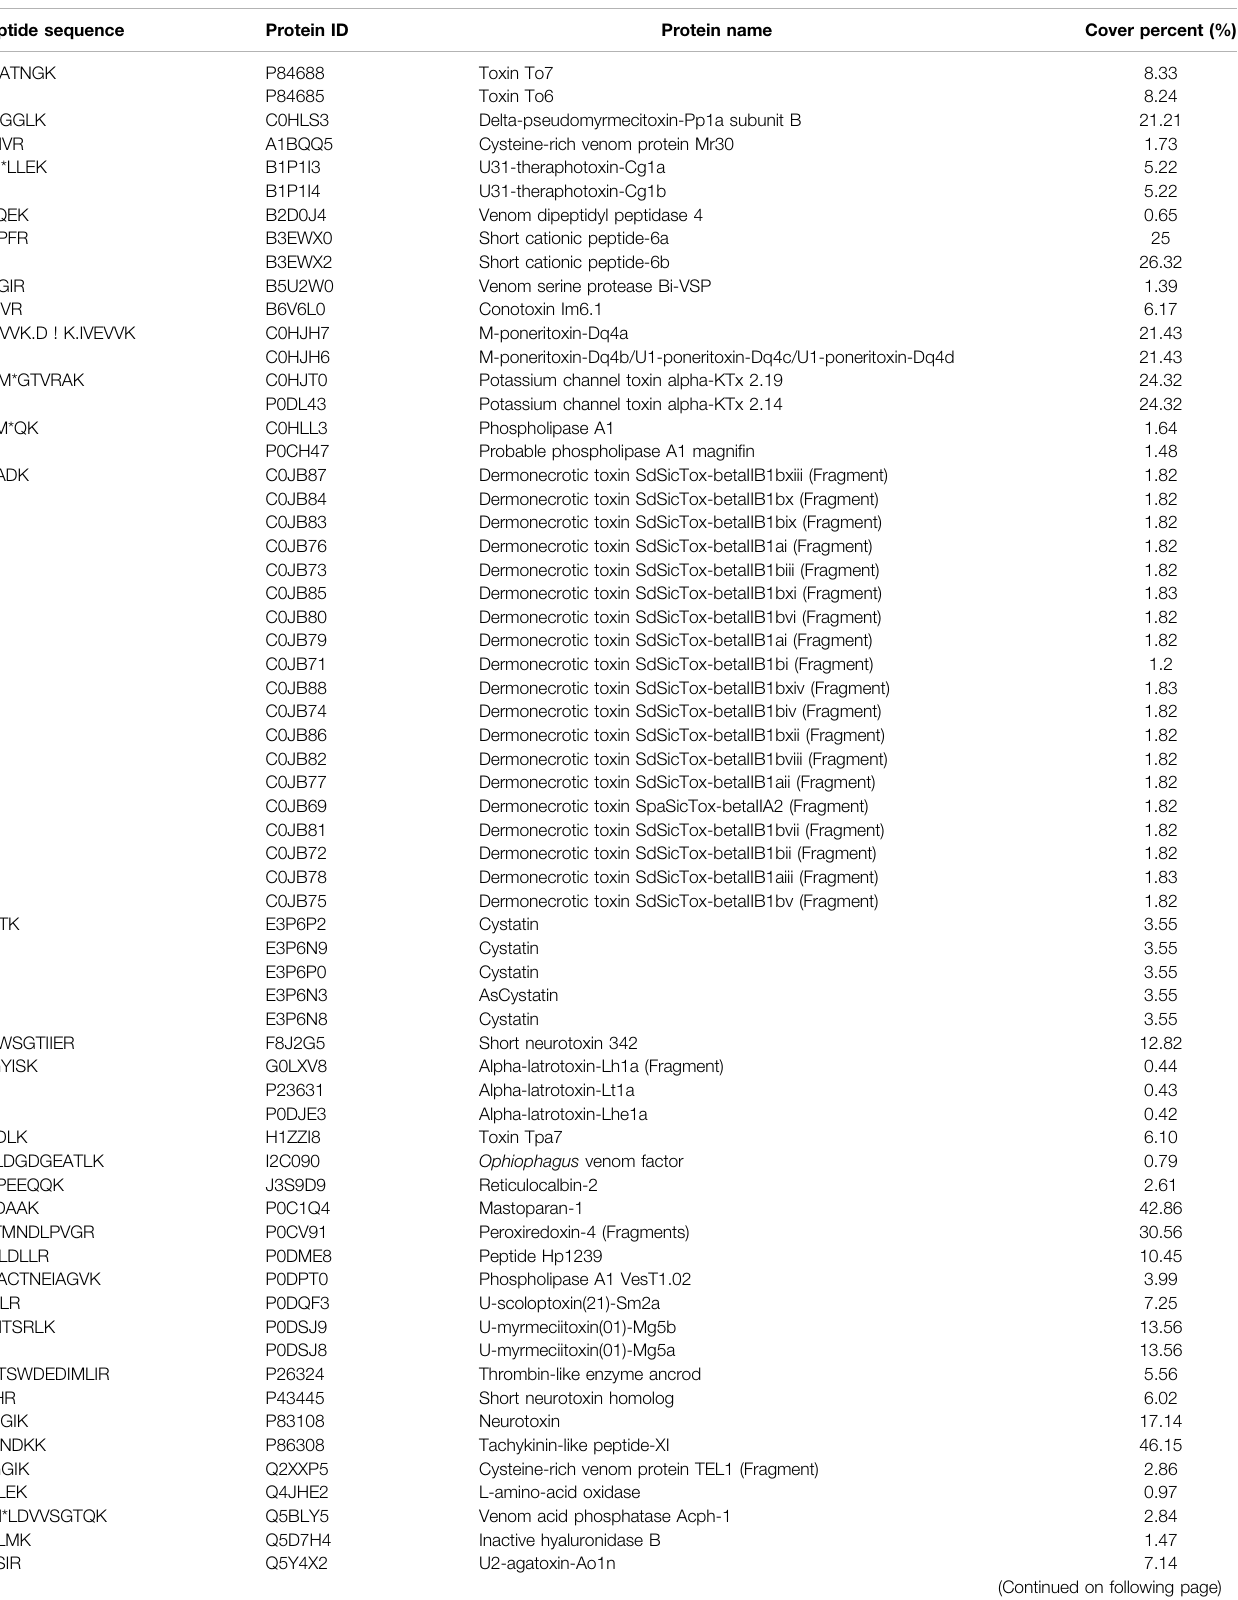
TABLE 1 | Toxins of NnTNV puri fi cation fraction C identi fi ed by LC-MS/MS analysis and Tox-Prot database. Peptide